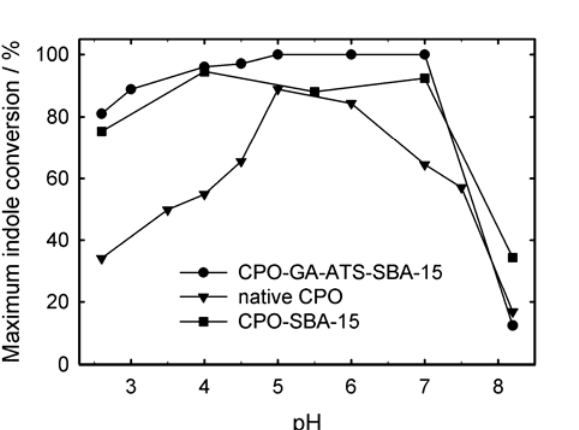
Figure 8. Indole oxidation over CPO-GA-ATS-SBA-15 (circle), CPO-SBA-15 (square) and native CPO (triangle) as a function of the pH of the reaction mixture. Catalyst amount: 2.5 U; T = 20 °C; substrate: indole (5 mL, 3.5 mM); oxidant: H R flow rate = 15 µL min − 1